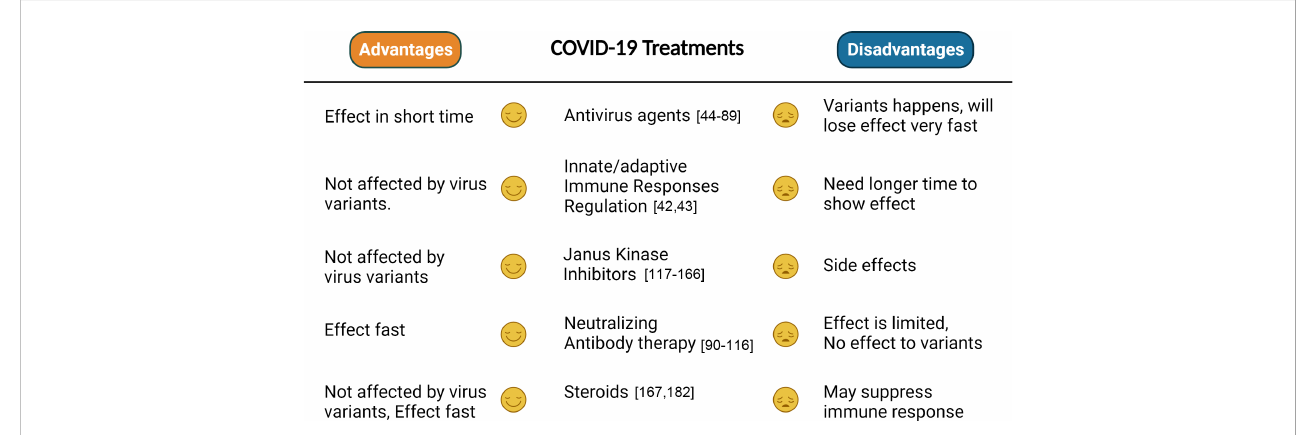
FIGURE 2 Comparison between different treatments. The advantages and disadvantages of each treatment are summarized on the basis of whether they will be ef fi cient to variants, have side effects, or effect